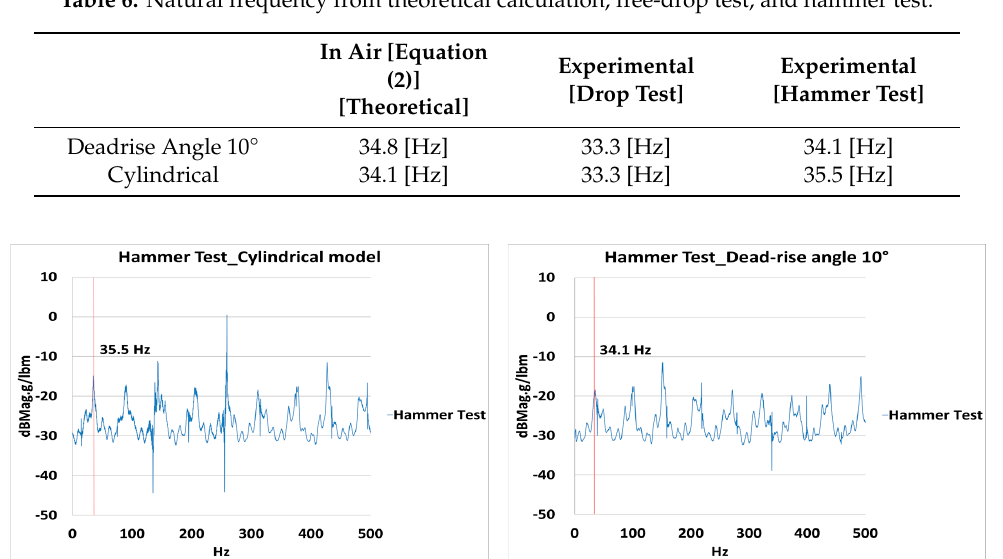
Table 6. Natural frequency from theoretical calculation, free-drop test, and hammer test.